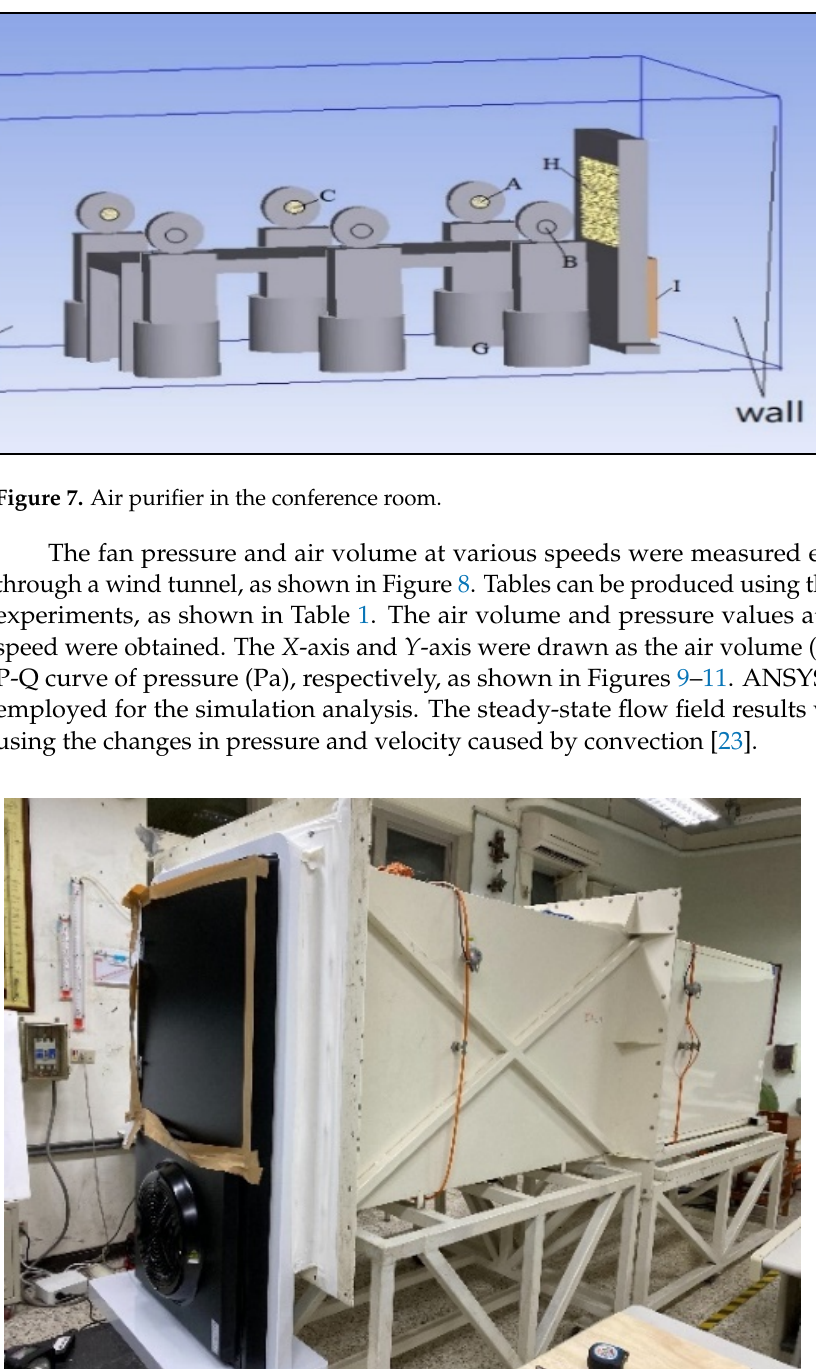
0.7271 Figure 9. P-Q curve of the air purifier at a low rotation speed.